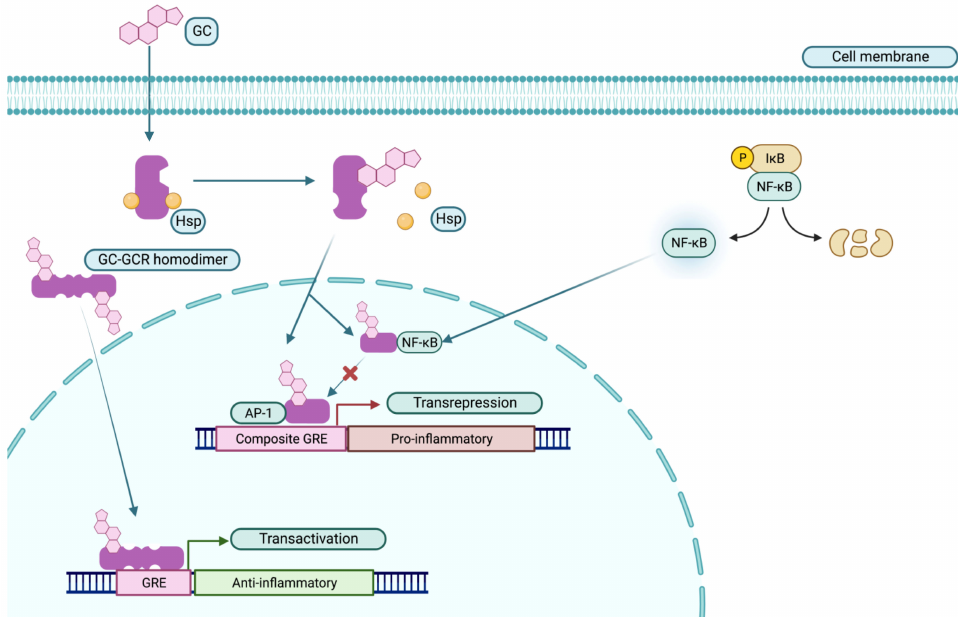
Figure 2. Genomic mechanisms of glucocorticoid-induced anti-inflammation. GCs bind to their cytosolic glucocorticoid receptor (GCR), which subsequently loses its chaperoning proteins, such as heat shock proteins (Hsp). Homodimers are formed, travel to the nucleus, bind to the glucocorticoid response element (GRE), and upregulate the expression of certain genes (e.g., lipocortin-1 and genes involved in metabolism), a mechanism called transactivation. Monomeric GC–GCR complex (mGC- GCR) can bind to transcription factors as AP-1 and NF-k β , inhibiting the transcription of their target genes (e.g., IL-2 and TNF α ) by a mechanism called transrepression. Further, direct binding of mGC-GCR alongside AP-1 on composite GREs lead to transrepression. Created with BioRender.com (accessed on 17 October